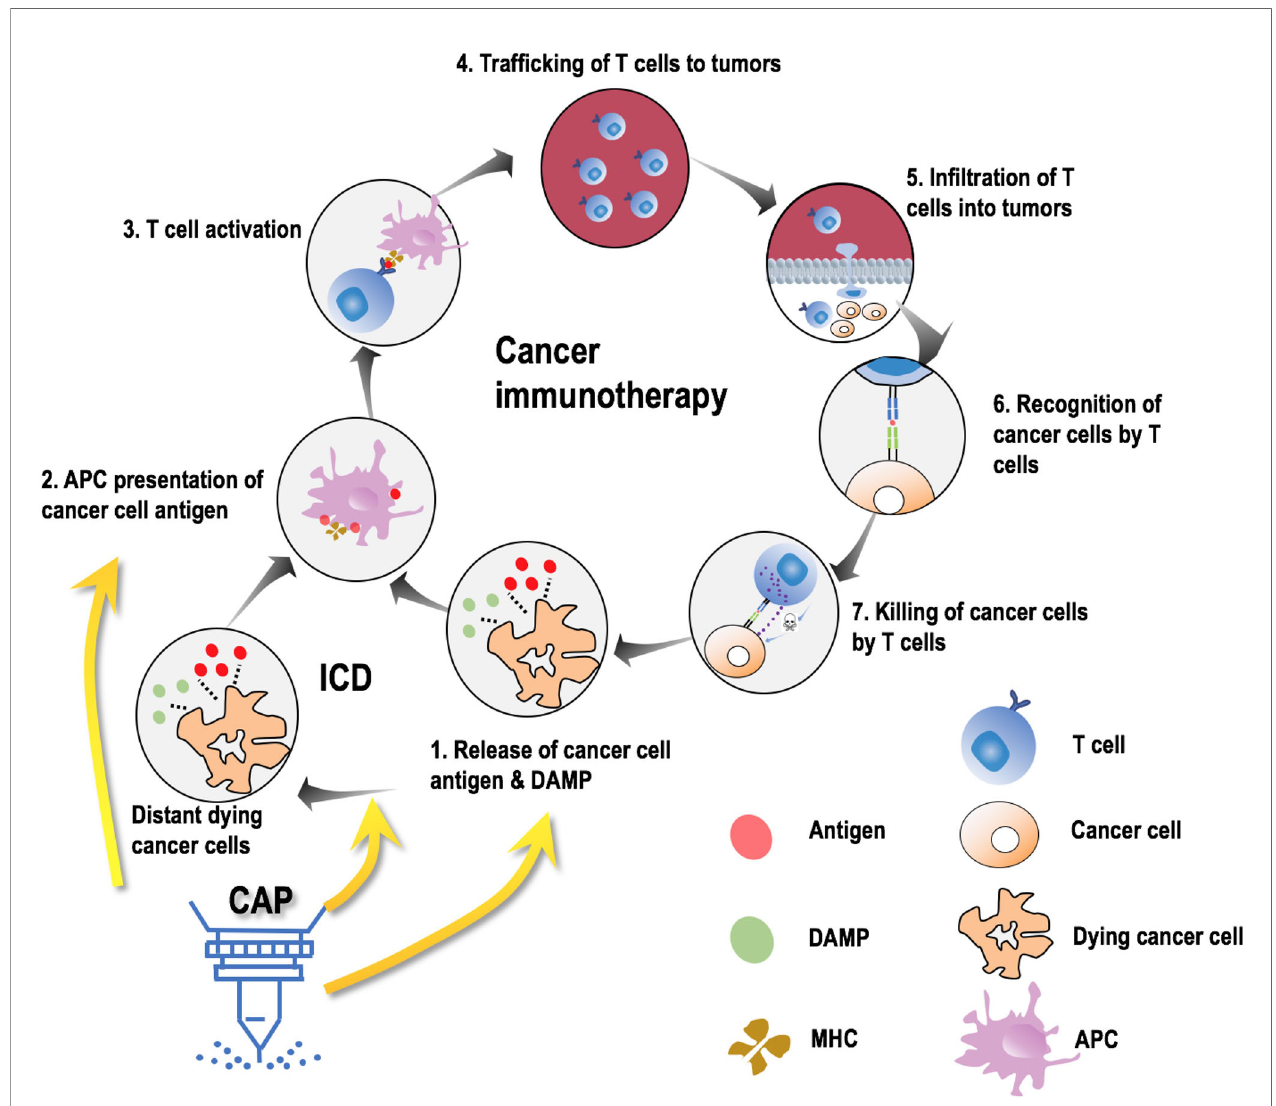
FIGURE 3 | Possible molecular mechanisms leading to synergies between CAP and onco-immunotherapies. Cancer immunotherapy is comprised of 7 steps, i.e., release of cancer cell antigens and damage associated molecular patterns (DAMPs), antigen presentation cell (APC) presentation of cancer cell antigens through major histocompatibility molecules (MHC), T cell activation, traf fi cking of T cells to the site of tumors, in fi ltration of T cells to tumors, recognition of cancer cells by T cells, and killing of cancer cells by T cells. Cold atmospheric plasma (CAP) avails in this process by primarily contributing to the fi rst two steps in three aspects, i.e., promoting immunogenic cell death (ICD), promoting MHC expression, facilitating DAMP